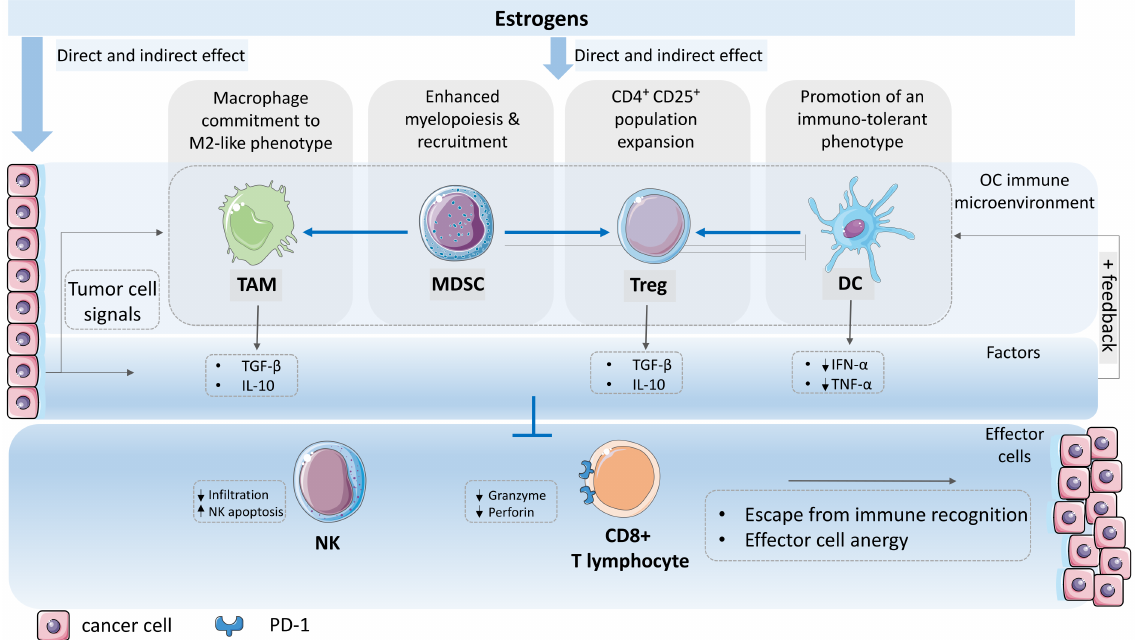
Figure 3. The immunosuppressive ovarian tumor microenvironment and the contribution of estrogens to its formation. Local and systemic estrogens reaching the ovarian tumor tissue affect various cells of the growingly immunosuppressive microenvironment. Immune cells are responsive to estrogens through receptors. Estrogens contribute to M2-like activation of macrophages and their accumulation in the tumor tissue. Furthermore, estrogens might enhance pathologic myelopoiesis, recruitment of immature myeloid cells (IMCs) to the tumor tissue and their conversion to myeloid derived suppressor cells (MDSCs). Moreover, estrogens stimulate the expansion of regulatory T (T reg ) cells, and might promote tolerogenic phenotype in dendritic cells (DCs). In addition, these immune cells of the microenvironment influence the activity of each other, for example, MDSCs might commit to M2-like tumor associated macrophages (TAMs) and T regs , which in turn inhibit DCs antigen-presenting actions. A plethora of soluble factors, such as TGF- β , IL-10 released in the microenvironment further stimulate the formation of an immunosuppressive microenvironment that inhibits effector CD8 + cells and NK cells. Consequently, CD8 + T lymphocytes present as less mature, produce less granzyme and perforine, and overexpress PD-1, which drives them to exhaustion. The inhospitable microenvironment restricts the NKs infiltration and induces their apoptosis, altogether leading to tumor escape from immune destruction. Parts of the figure were drawn by using